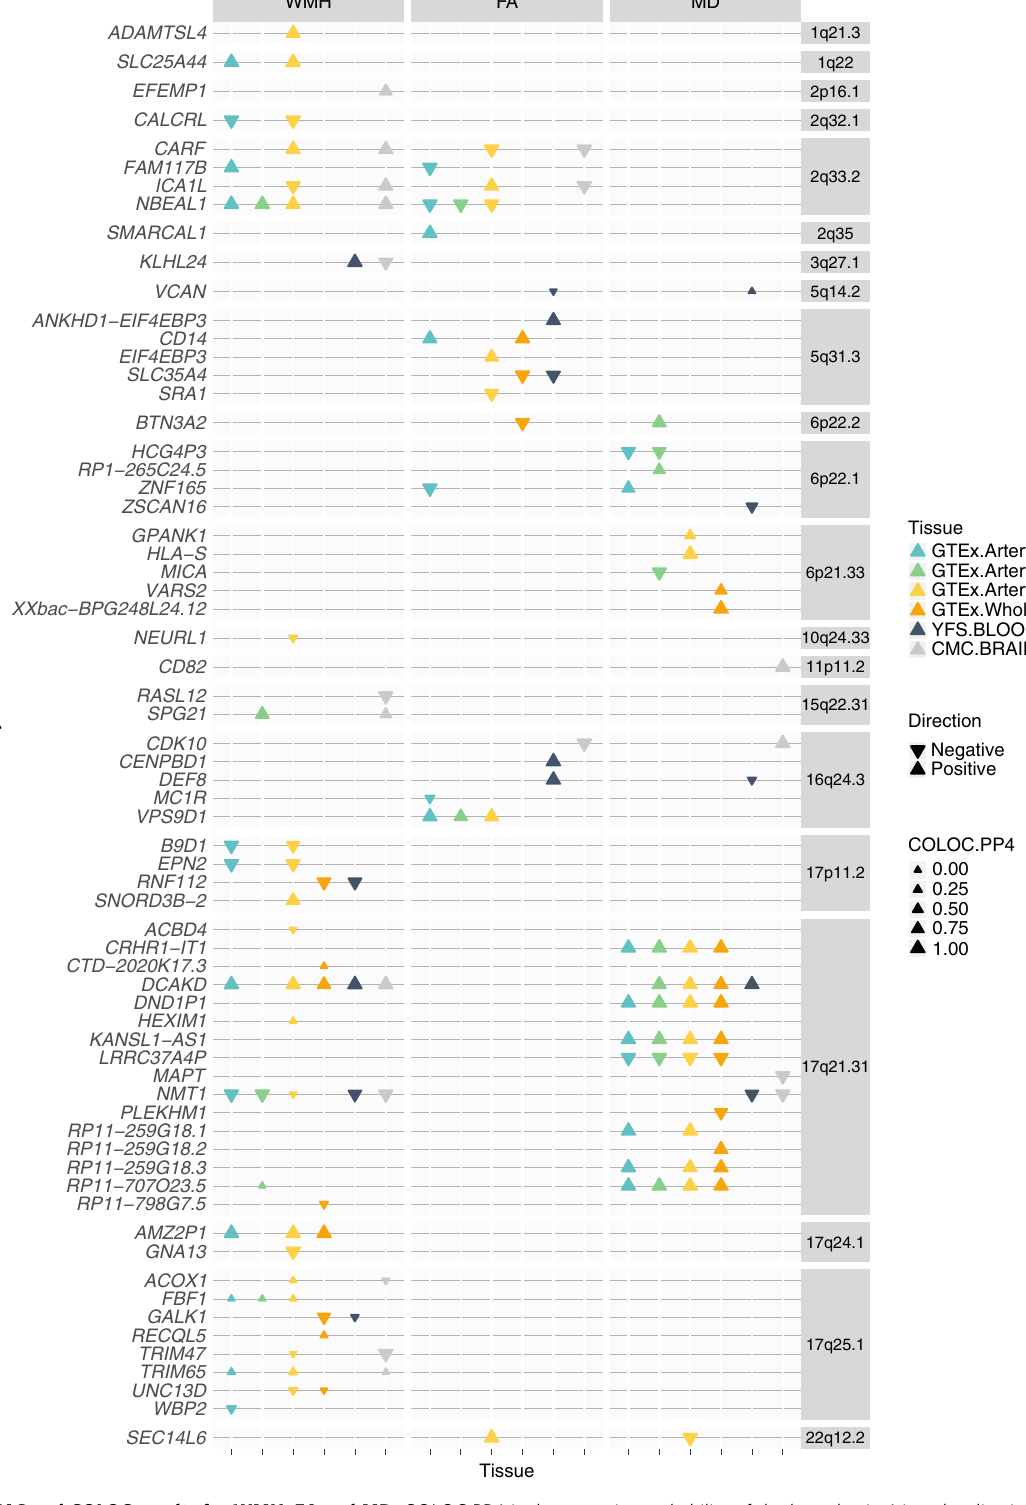
Fig. 5 TWAS and COLOC results for WMH, FA and MD. COLOC.PP4 is the posterior probability of the hypothesis 4 in colocalization analysis, meaning there is association with the imaging biomarker trait and the gene expression and with one shared